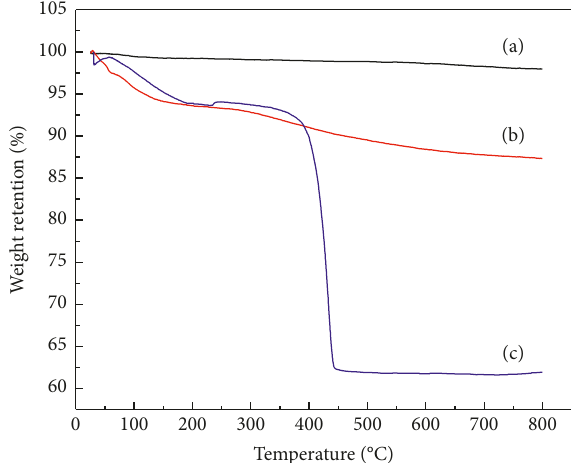
Figure 4: TGA curves of (a) SiO PNIPAM.